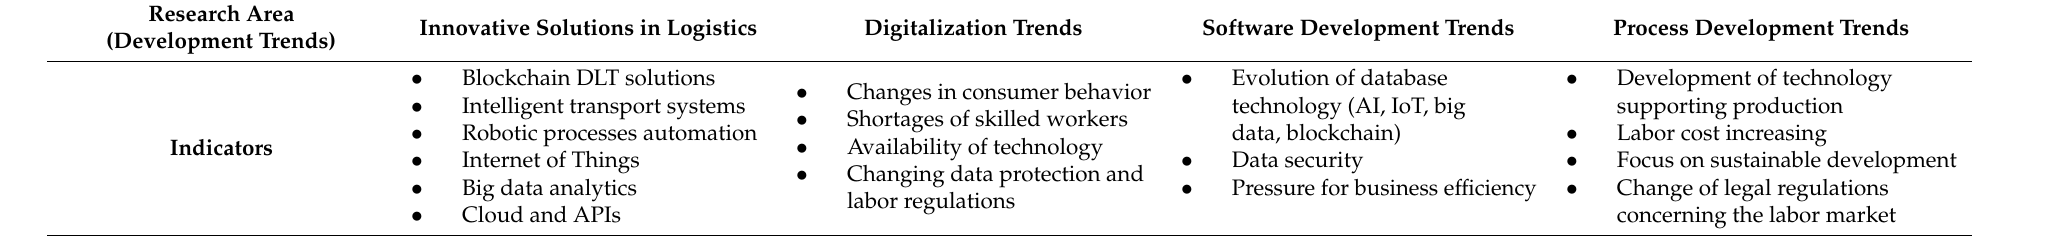
Table 4. Indicators in research areas.